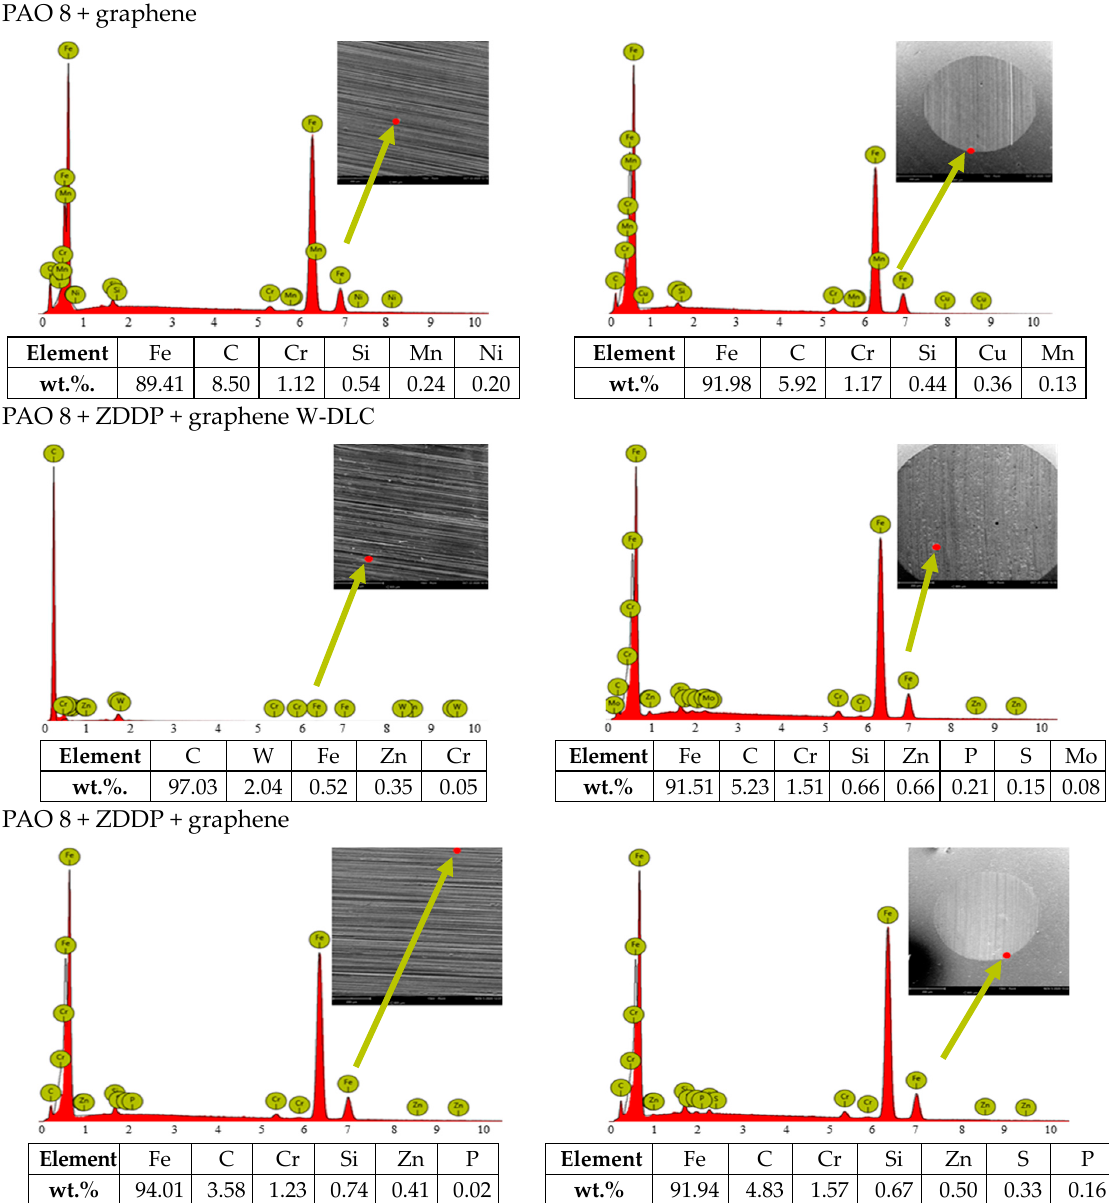
Figure 6. SEM images: surface morphologies and characteristic spectra (EDS) in the selected microareas along the wear tracks on the discs and balls after fiction contact.